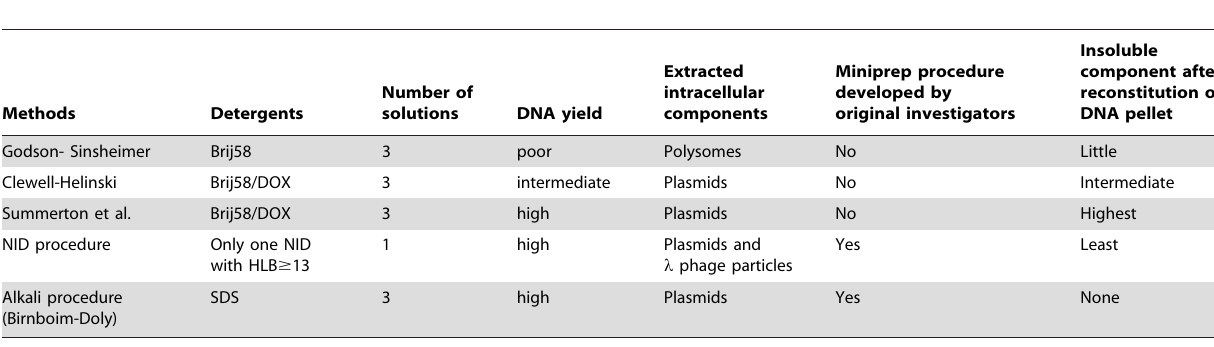
Table 2. Main features of various bacterial extra-chromosomal element isolation